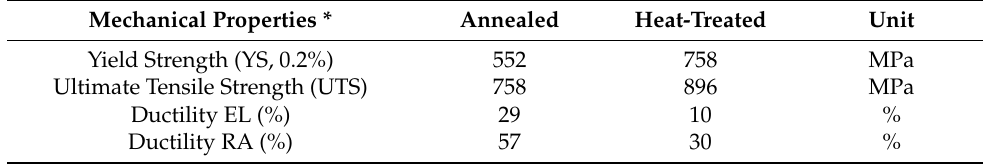
Table 5. Mechanical properties of